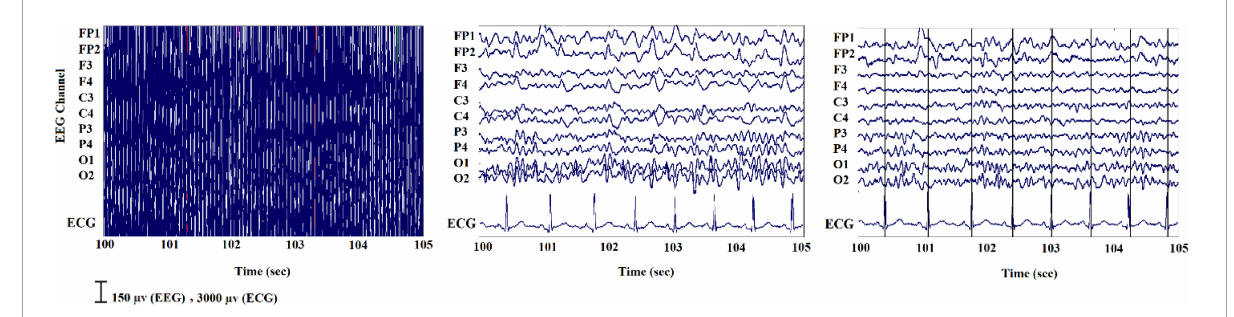
FIGURE6 A sample of EEG signals recorded inside the scanner: (Left) primary signal; (Middle) after eliminating the MR gradient artifact; (Right) after removing the BCG artifact (Ebrahimzadeh et al.,